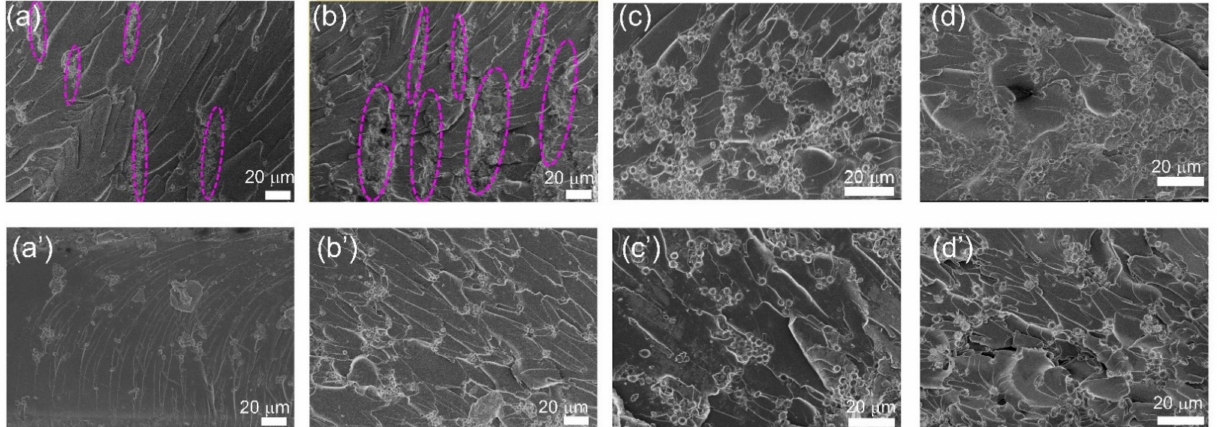
Figure 8. Cross-sectional morphology of Ni@PS/EP composites obtained with 300 V/mm of electric field strength at different Ni@PS content (wt.%): ( a ) 5, ( b ) 10, ( c ) 15, ( d ) 20. ( a’ – d’ ) Corresponding to the composites containing 5 wt.%, 10 wt.%, 15 wt.%, and 20 wt.% of Ni@PS without application of electric